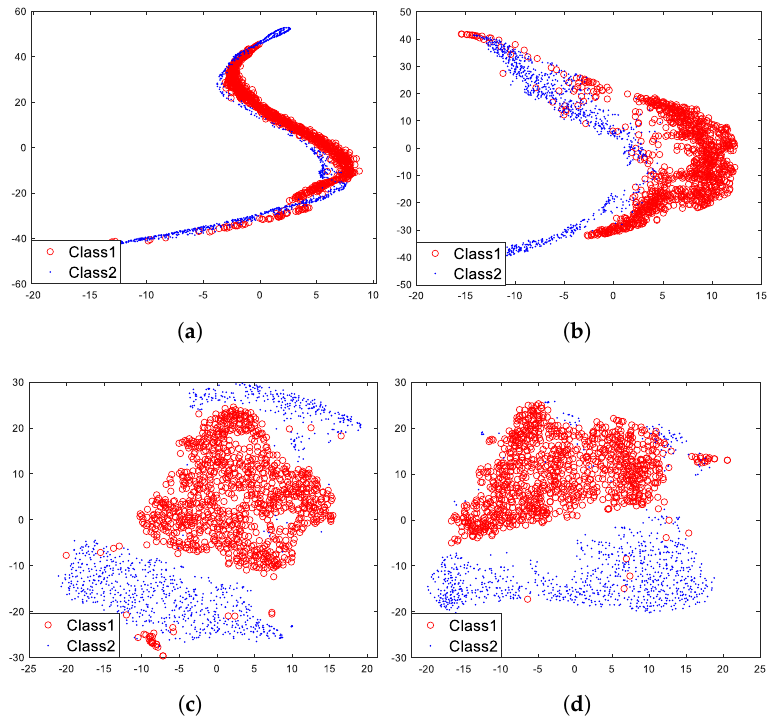
Figure 14. Feature visualization after fine-tuning with the traditional supervised training algorithm.